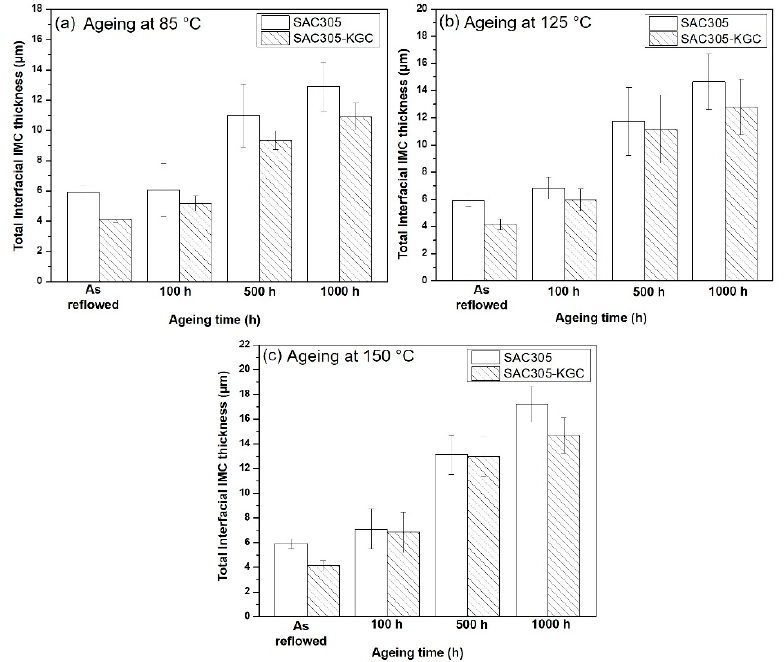
Figure 11. Total interfacial IMC thickness subjected to isothermal ageing at temperature of ( a ) 85 ◦ C and ( c ) 150 ◦ C. °C, ( b ) 125 °C and ( c ) 150 °C. ( b ) 125